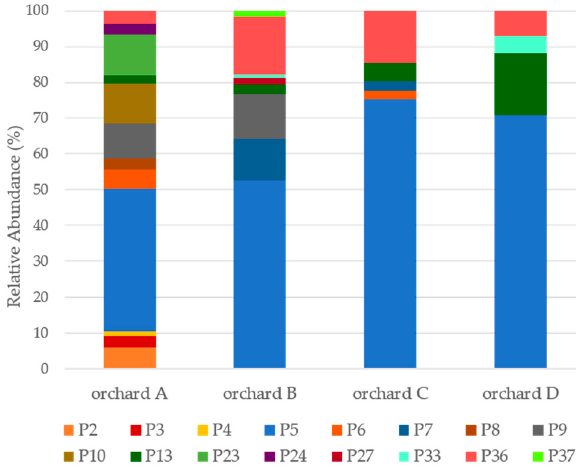
Figure 1. Psa population structure in orchard A to D.